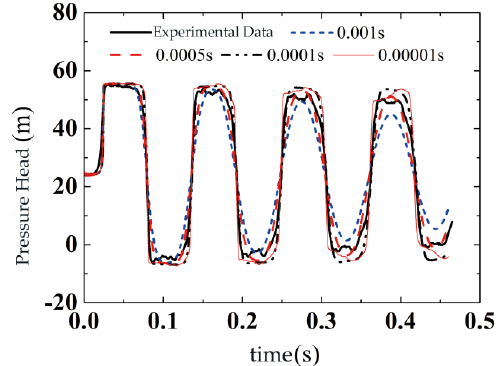
Figure 5. Comparison of cross-sectional average pressure fluctuations at the S3 position of different time steps.